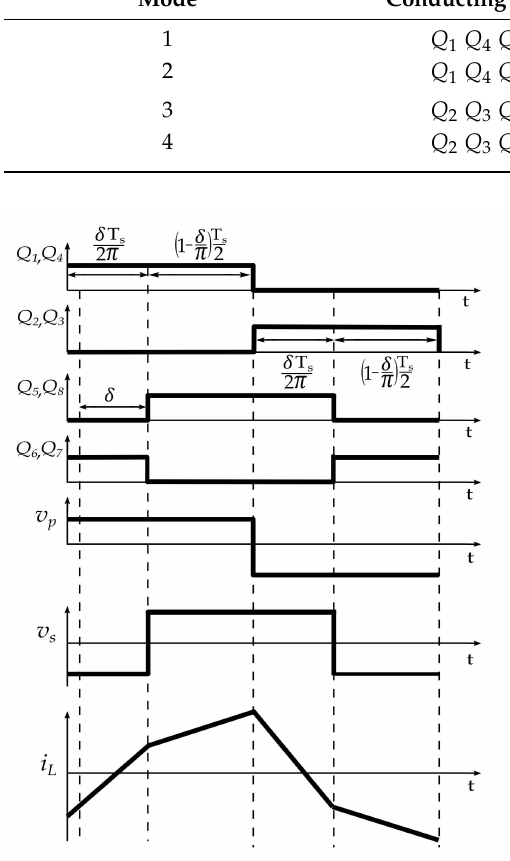
Figure 3. General SPS-DAB switching sequence and related main